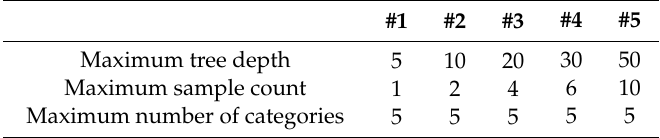
Table 5. The combinations of parameters for the random forest